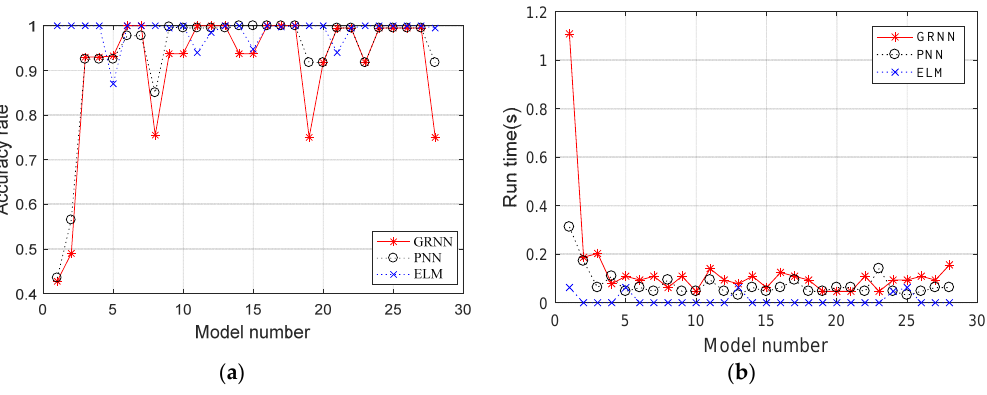
Figure 9. Test results of each model. ( a ) Test set accuracy of each model (GRNN vs. PNN vs. ELM); ( b ) Running time of each model (GRNN vs. PNN vs. ELM).